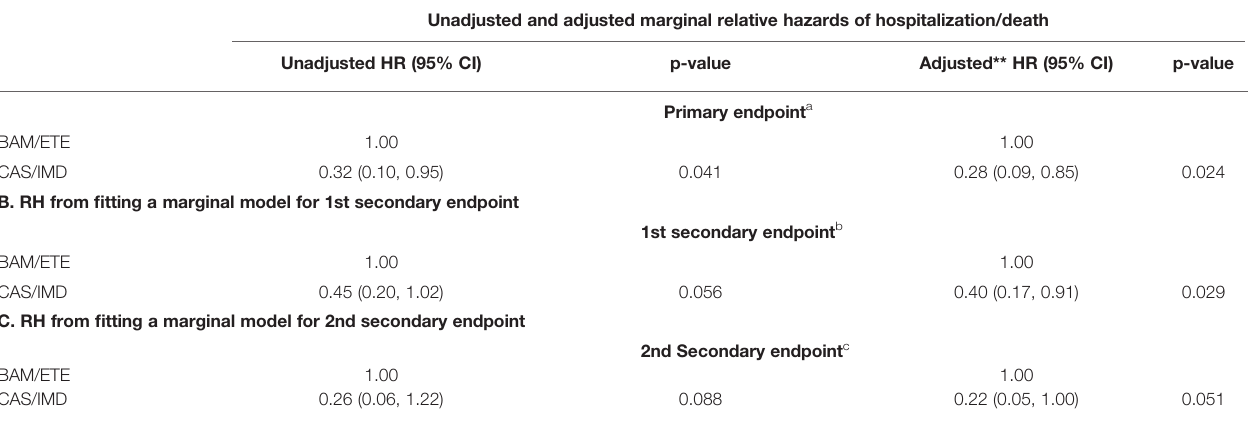
TABLE 3 | Relative hazard from fi tting a marginal model using BAM/ETE as the comparator group for primary (A) and secondary endpoints (B, C).